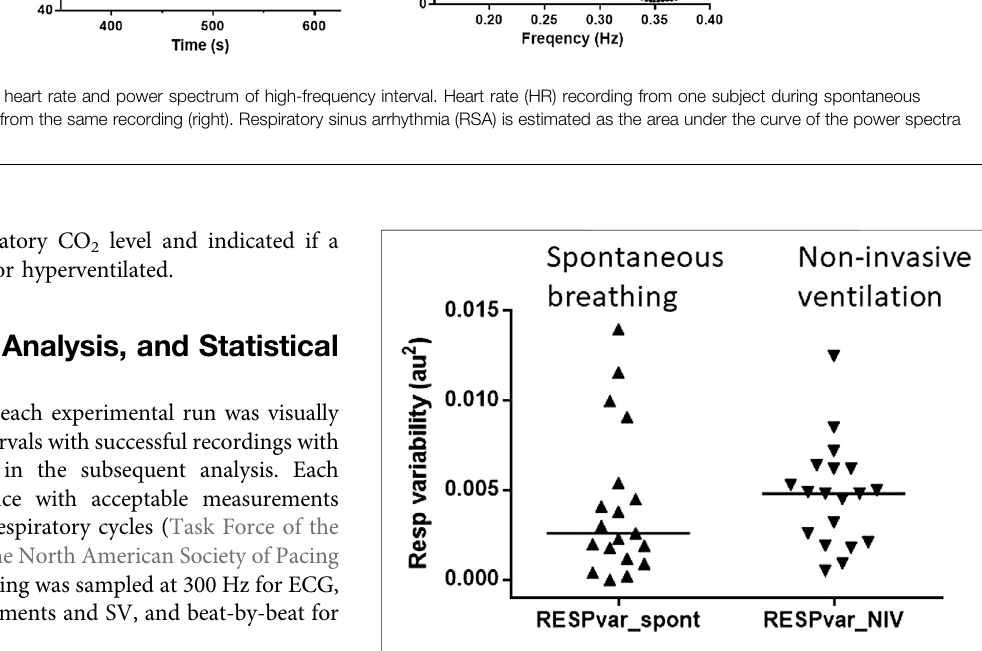
FIGURE2| Pulmonarystretchinputwasmaintainedduringnon-invasive ventilation. Variability in respiratory band stretch during spontaneous breathing (left) and non-invasive ventilation (right). The triangles represent the subjectineachcondition.Themedianisindicatedbythehorizontalbars. The variability in the stretch of the respiratory band was similar during spontaneous breathing and non-invasive